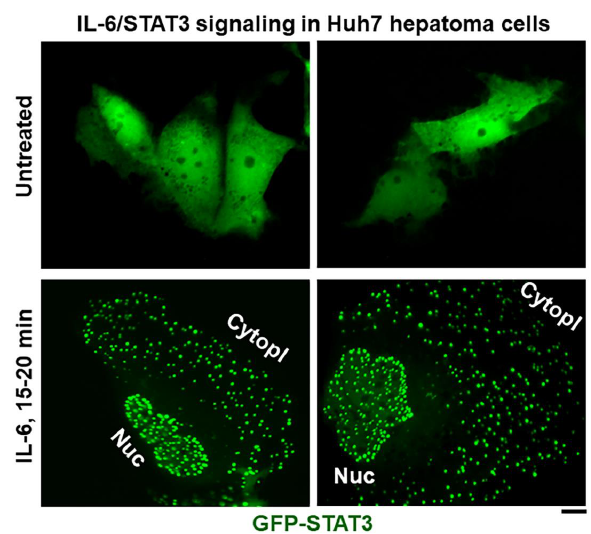
Figure 4. IL-6-induced cytoplasmic and nuclear GFP-STAT3 bodies (“biomolecular condensates”) in Huh7 hepatoma cells. Sub-confluent cultures of Huh7 cells in 35 mm plates that had been transiently transfected with the pGFP-STAT3 expression vector one day earlier were imaged using live-cell microscopy without IL-6 exposure or after exposure to IL-6 (20 ng/mL) for 15–20 min Nuc–nucleus, Cytopl–cytoplasm. Scale bar = 25 μm. Adapted from Sehgal, 2019 [65].